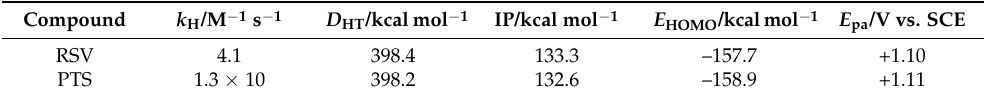
Table 1. Experimental k H values in MeCN, calculated D HT , IP and E HOMO values by DFT, and exper-